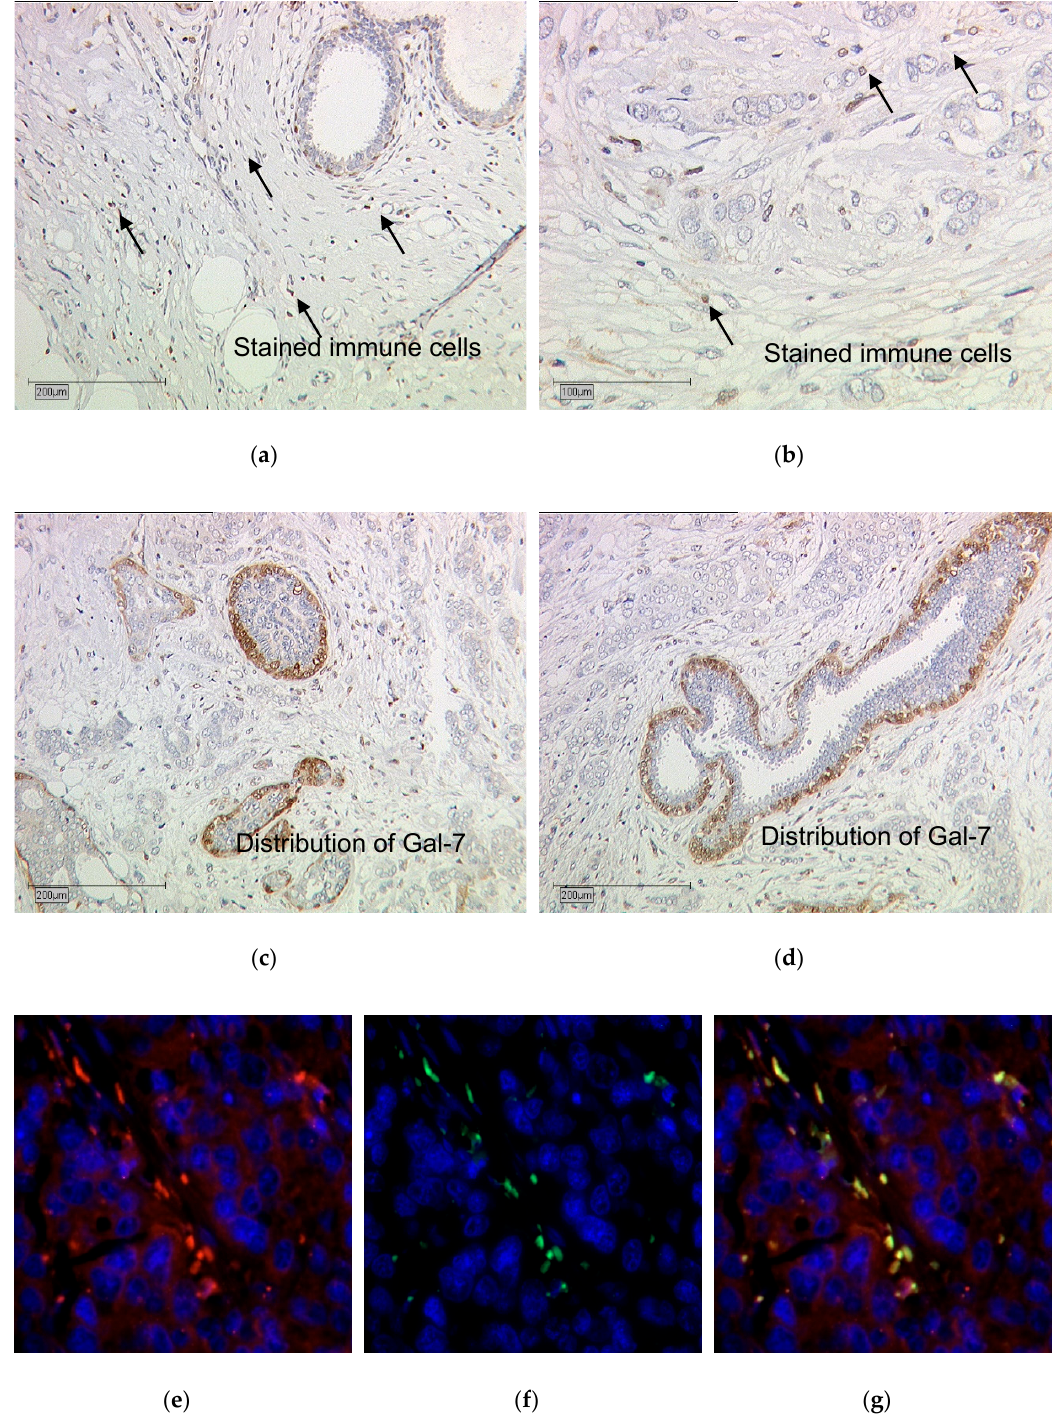
Figure 8. Gal-7-staining results ( a – d ) and double immunofluorescence staining with Gal 7 and CD68 ( e – g ). Exemplary pictures of Gal 7-staining results are shown, revealing the distribution of Gal 7-staining in tumor cells ( a , b ). Stained immune cells in Gal 7-expressing tumors are shown in ( c ) and ( d ). Immunofluorescence results: Gal-7 is shown in red ( e ), CD68 in green ( f ) and the nucleus is stained with DAPI in blue. Picture ( g ) shows that Gal 7- and CD8-staining is overlapping in some cells, which appear yellow, showing that these are macrophages. Magnification: Images 8a, 8c and 8d x10, and images 8b, 8e, 8f and 8g x25.